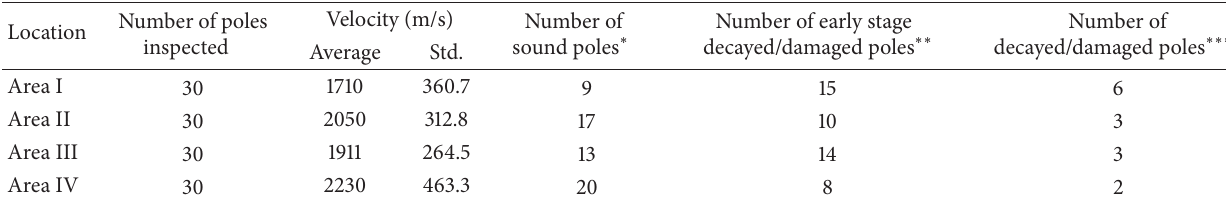
Figure 10: Some resistograph outputs for the utility poles inspected in Artvin vicinity. Table 2: Micro Hammer inspection